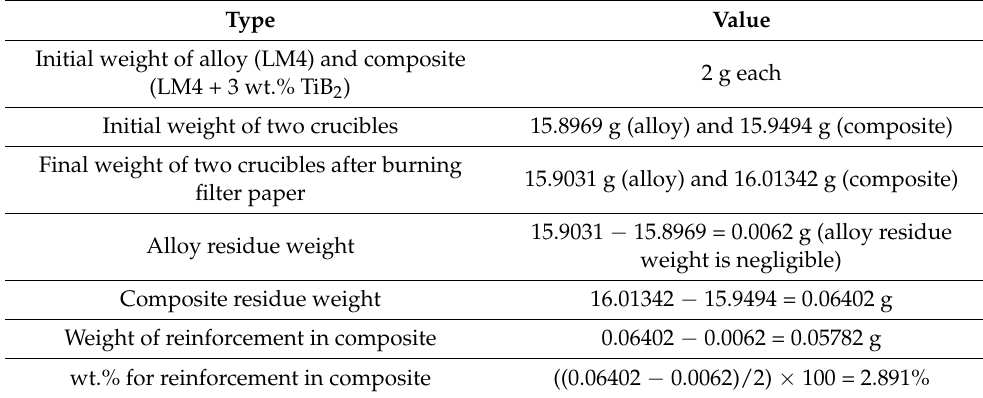
Table 3. Experimental data of the chemical analysis